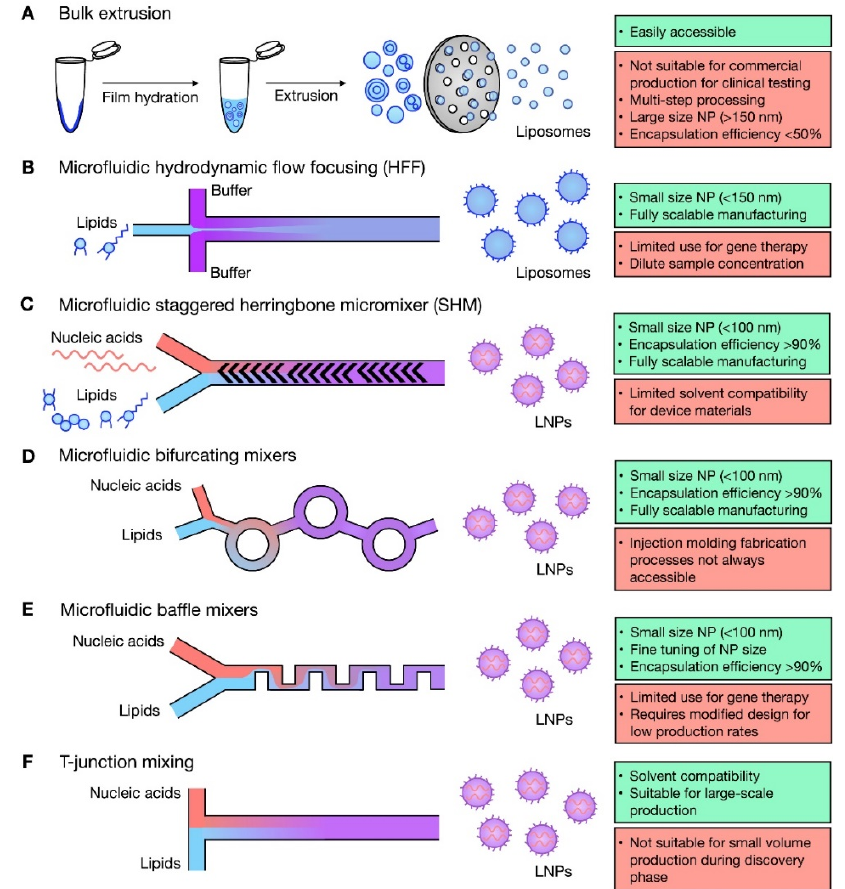
Figure 4. Microfluidic techniques for liposome and lipid nanoparticle (LNP) formulation . Summary of bulk and microfluidic techniques for production of liposomes ( A , B ) and lipid nanoparticles ( C – F ), highlighting advantages (green) and disadvantages (red) for each. Reproduced with permission from [227] and used under the Creative Commons license permission (CC BY 4.0). Copyright 2021, Elsevier Ltd. All rights reserved.